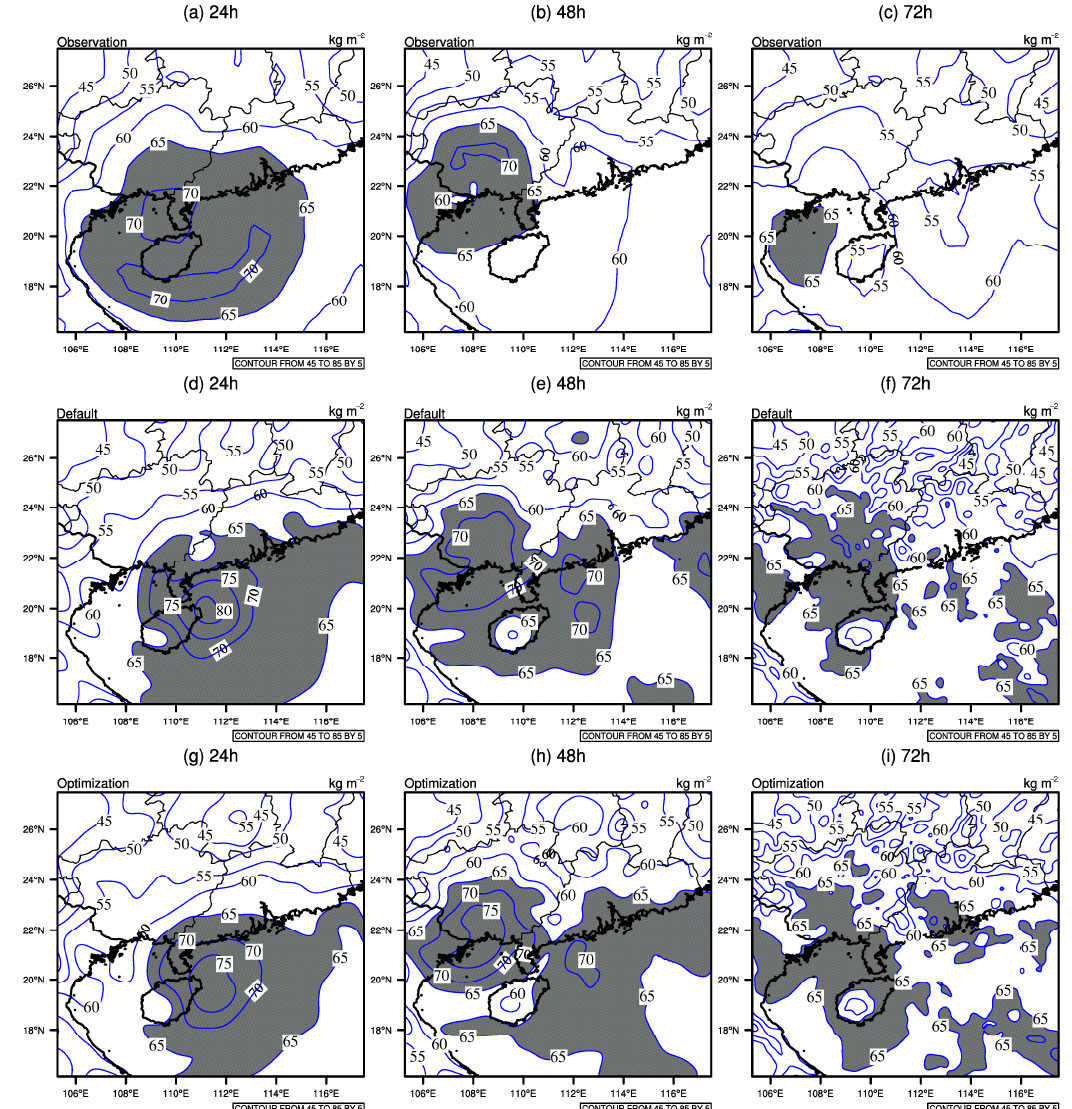
Figure 11. Comparisons of simulated precipitable water for event (2) at lead times of 24, 48, and 72 h. The shaded areas represent values higher than 65 kg m − 2 . ( a )–( c ) represent the observed precipitable water at 24, 48, and 72 h lead times respectively; ( d )–( f ) represent the simulated precipitable water with default parameters at 24, 48, and 72 h lead times respectively; ( g )–( i ) represent the simulated precipitable water with optimal parameters at 24, 48, and 72 h lead times respectively.